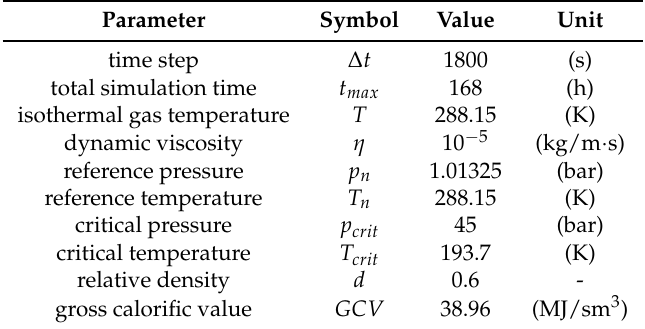
Table 5. Input parameter for transient simulation of GNET90 gas network